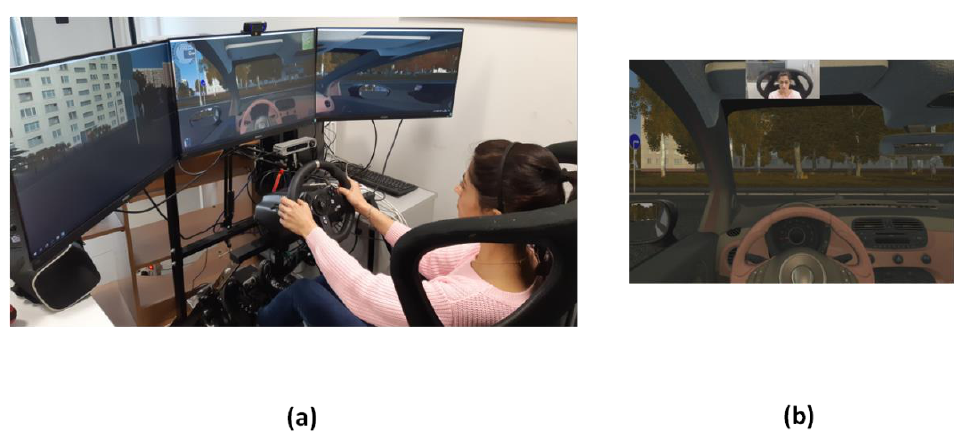
Figure 1. Experimental setting: ( a ) static driver simulator; ( b ) screenshot of the driving simulation software (i.e., City Car Driving, Home Edition software-version 1.5, Forward Development, Ltd., Verona (WI), USA [37] ).